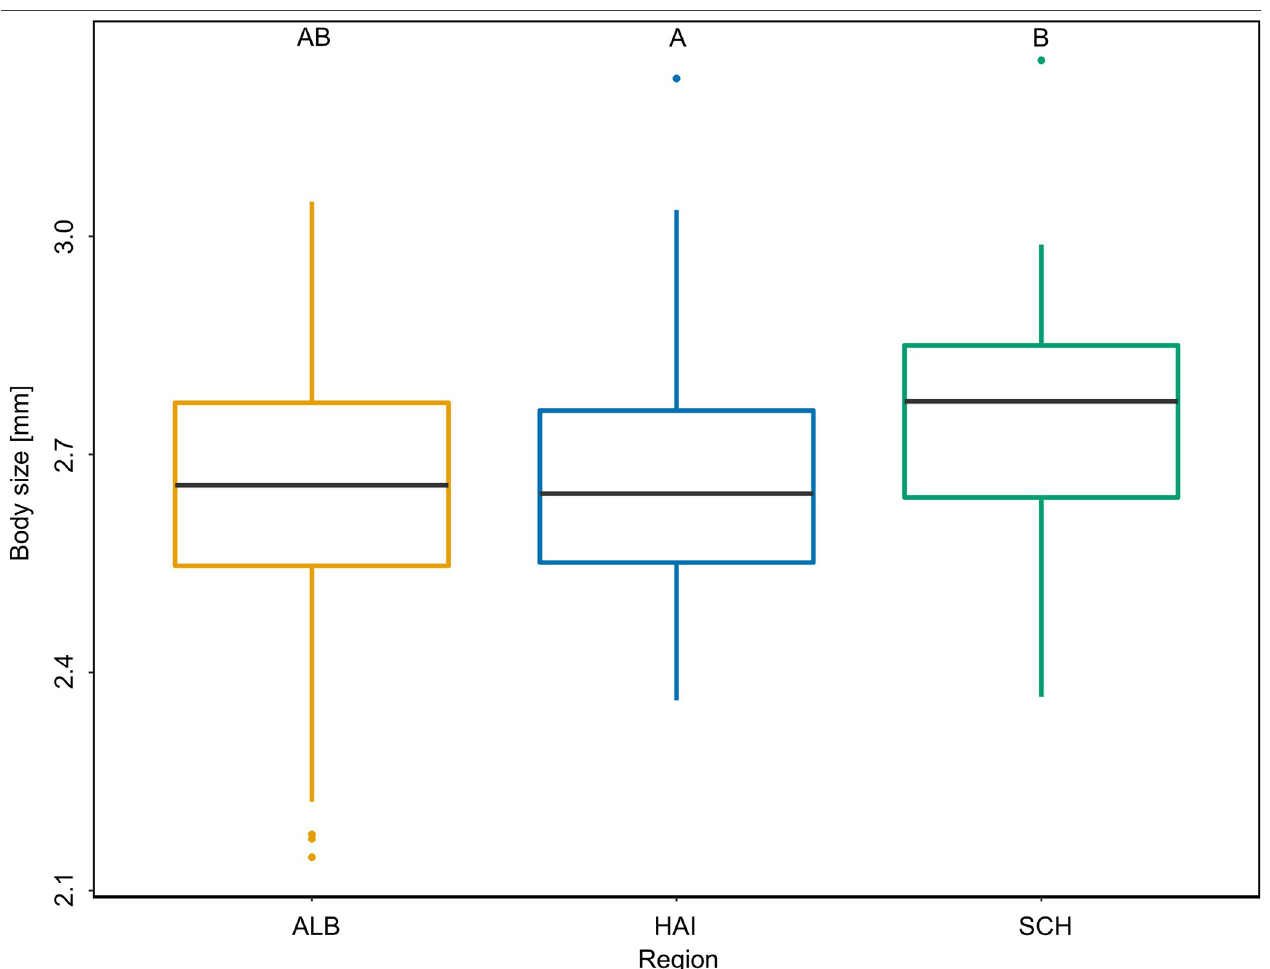
Fig 4. Comparison of body size of B . lapidarius workers in the various sampling regions. Body size of workers significantly differed in the three regions, namely Schwa¨bische Alb (ALB), Hainich-Du¨n (HAI), and Schorfheide-Chorin (SCH) (LMM: χ 2 = 6.682, N = 307, p < 0.05). Boxplots show the median range, interquartile range, and the minimum and maximum ranges. Outliers are shown as individual dots. Different capital letters indicate significant differences among groups.